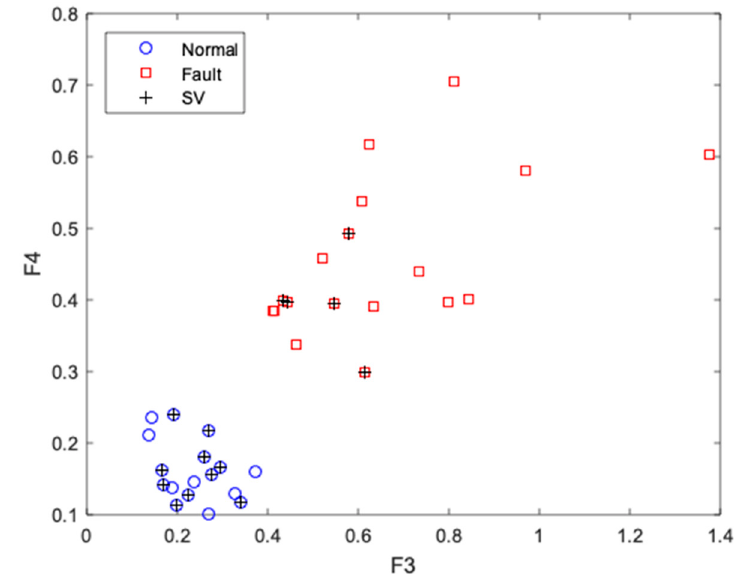
Figure 13. Sample points and support vectors by F 3 and F 4.